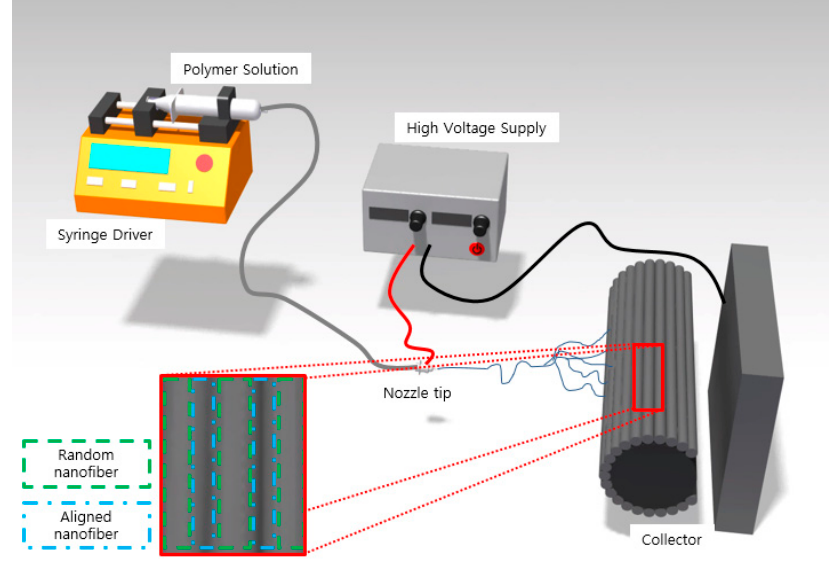
Figure 10. The schematic diagram for fabricating nanofiber mat.